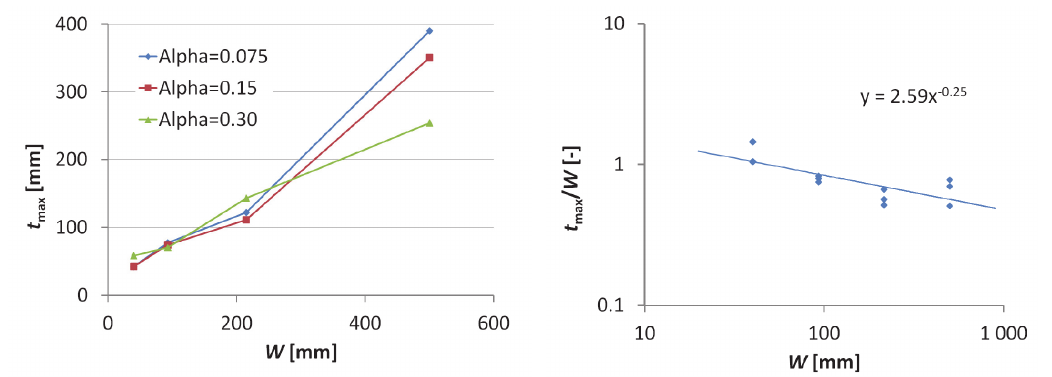
Figure 8: Maximum width of the FPZ extent envelope for all specimen sizes: Dependencies plotted individually for each notch length (left), regression of all the data by power function.